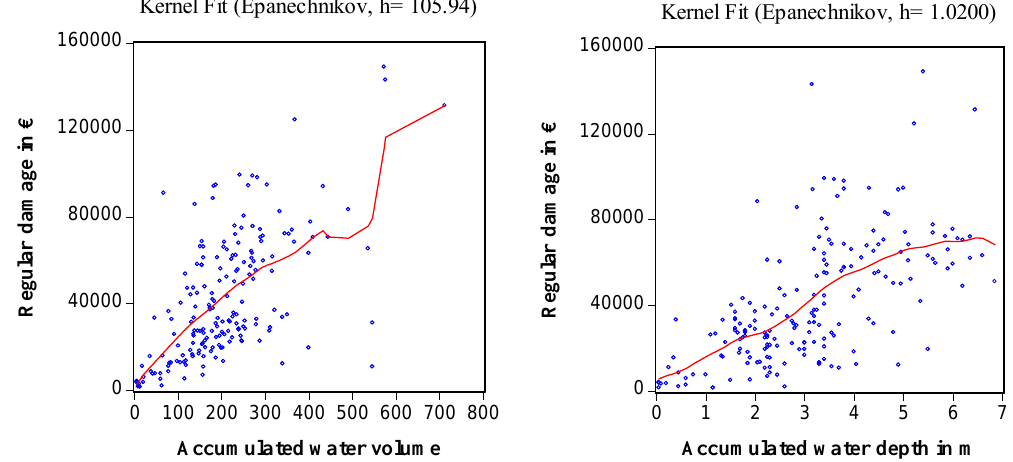
Fig. 4. Scatter plot with the water-volume- and water-depth-damage (Epanechnikov-kernel with bandwidth h ) for regular damage. Data source: Amt der N ¨ O Landesregierung, Abteilung Landwirtschaftsf¨orderungen (2006a).